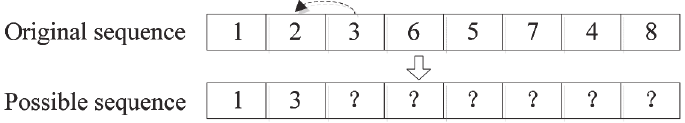
Figure 8. Example of assembly order errors